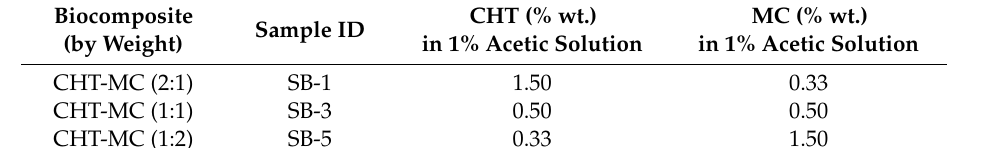
Table 1. Three di ff erent composite formulations with di ff erent weight ratios of chitosan (CHT) and MC.